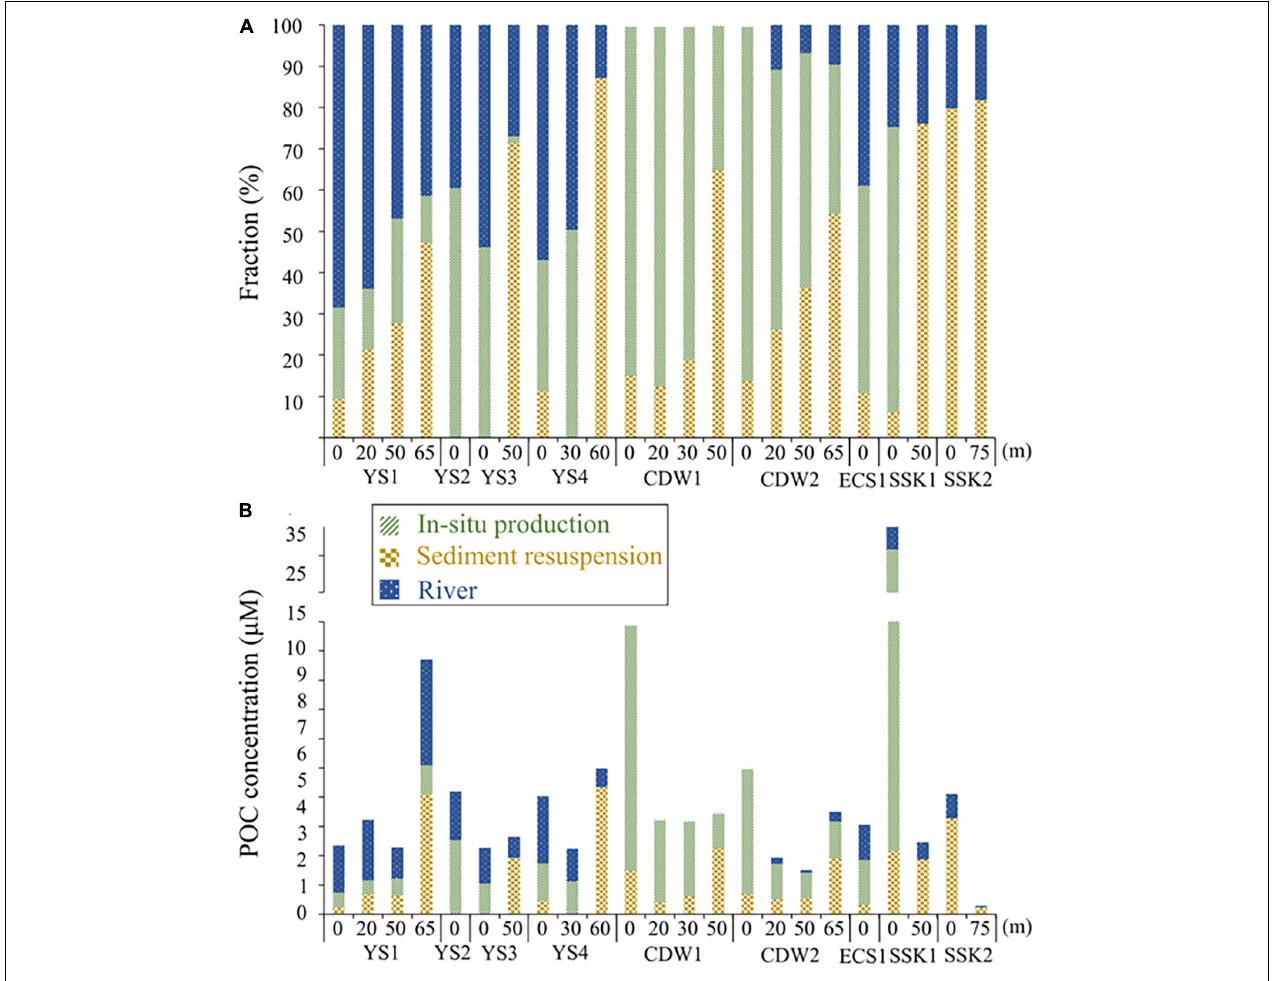
FIGURE 6 | (A) Relative and (B) actual contribution of each source to POC (green = in situ production, yellow hatched = sediment, and blue = riverine